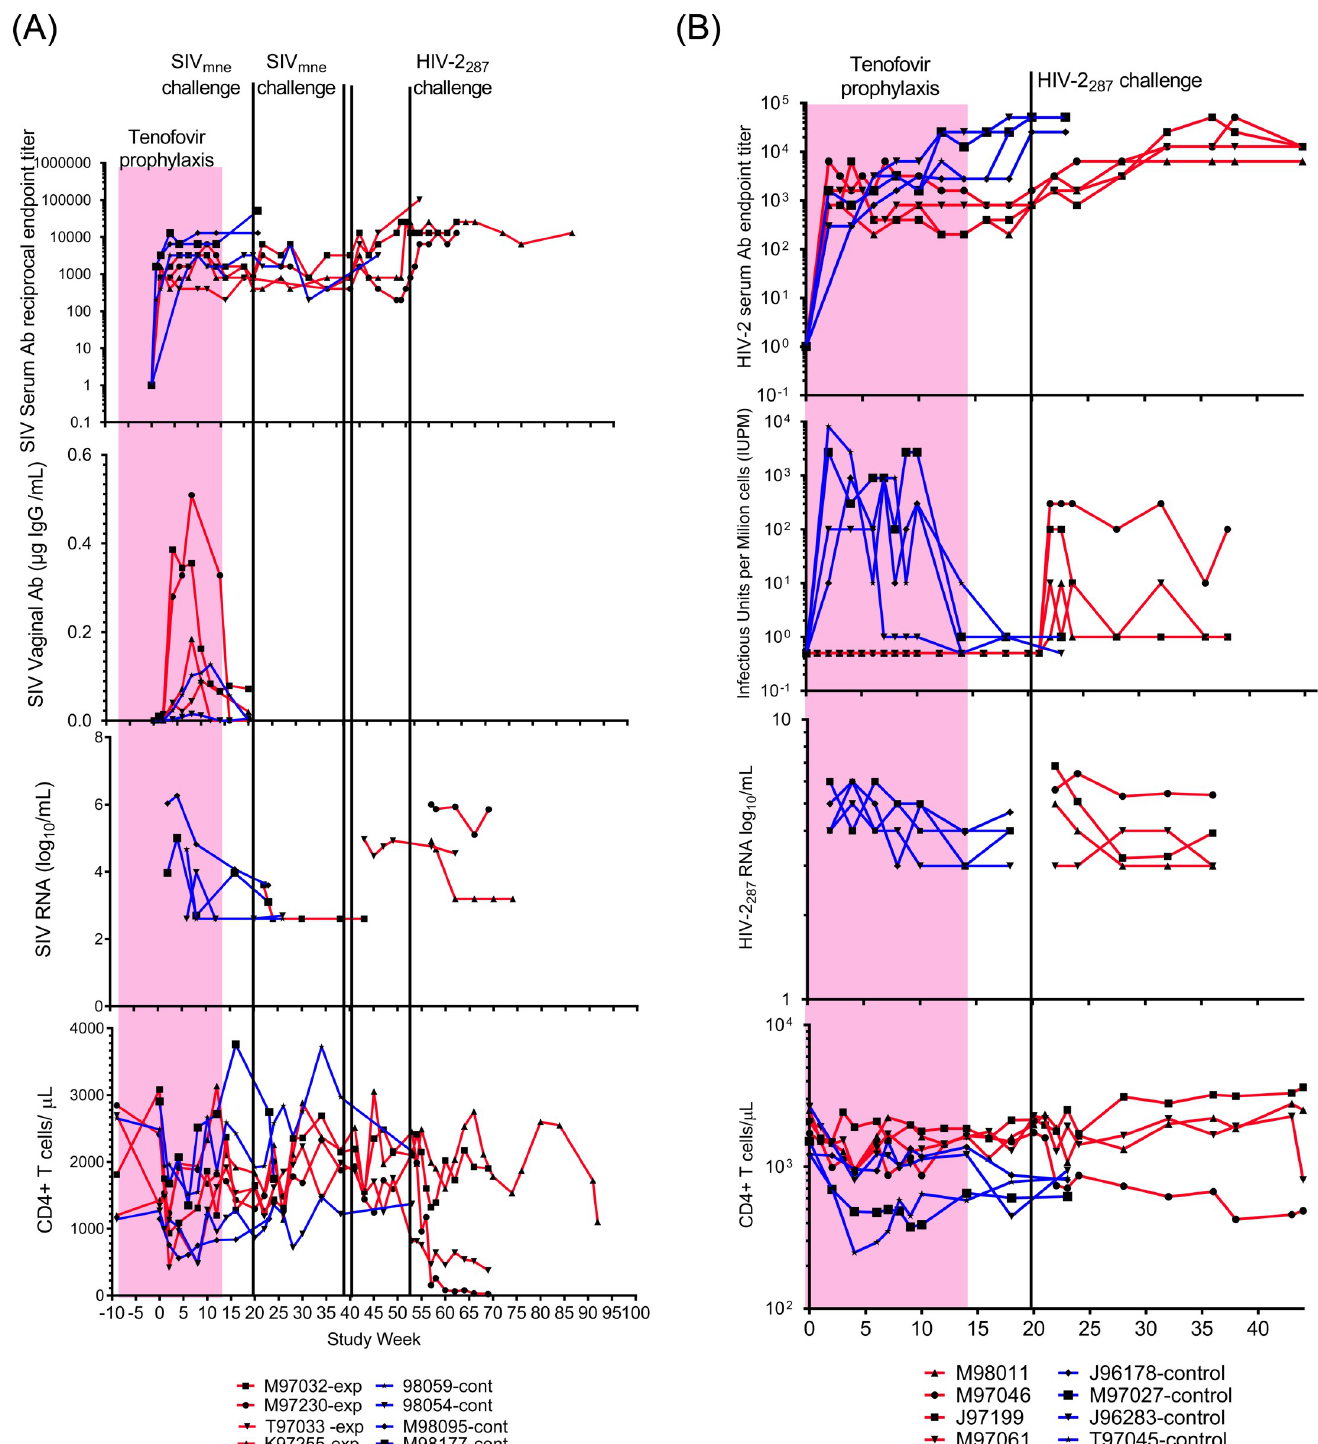
Fig 2. Macaques immunized to SIV/HIV-2 by exposure to virus during tenofovir prophylaxis resisted viral challenge and demonstrated protection from disease. A . Panels show SIV serum (top) and vaginal (second from top) IgG antibody levels, plasma viral load (third from top), and peripheral blood CD4 + lymphocyte concentrations (bottom) for control (blue lines) and experimental (red lines) macaques. Tenofovir (pink block) was given to experimental group from Study Week 0–14. Experimental animals had intravaginal challenges with SIV Mne (green lines). One experimental animal, M97032, was infected by the first challenge of 10 4 TCID 50 of SIV mne grown in homologous cells. A second animal, T97033, was infected by the second/third challenge with two doses of 10 4.5 TCID 50 SIV mne